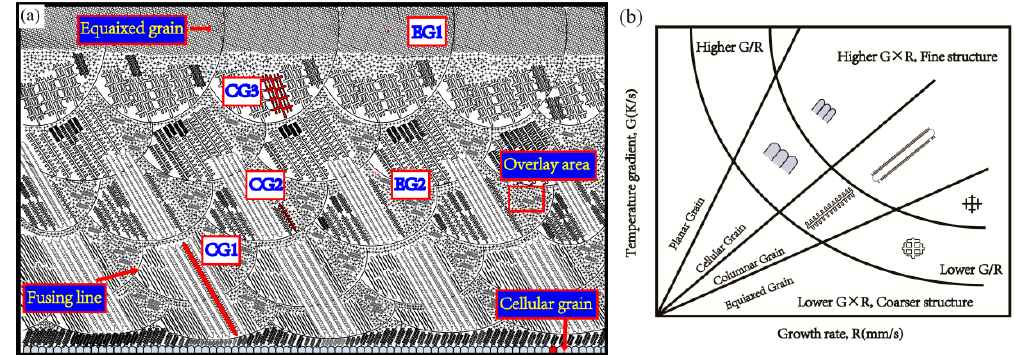
Figure 3. ( a ) The microstructure sketch of deposited specimen; ( b ) Effect of temperature gradient G and growth rate R on the morphology and size of solidification microstructure [32].